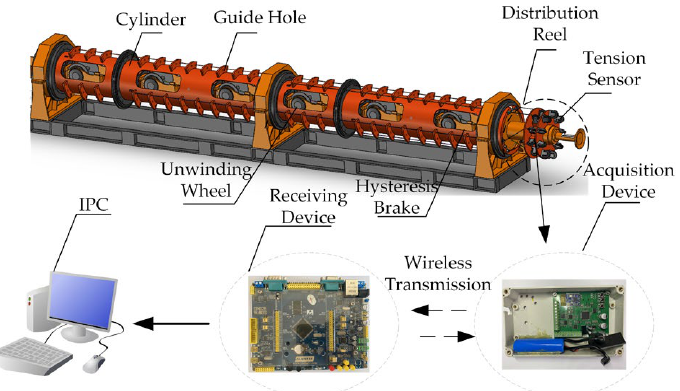
Figure 1. Strand-twisting production schematic diagram.